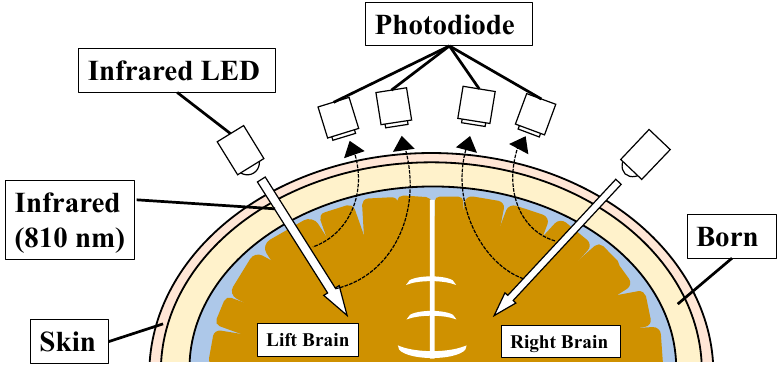
Figure 4. Principle of cerebral blood flow meter measurement.